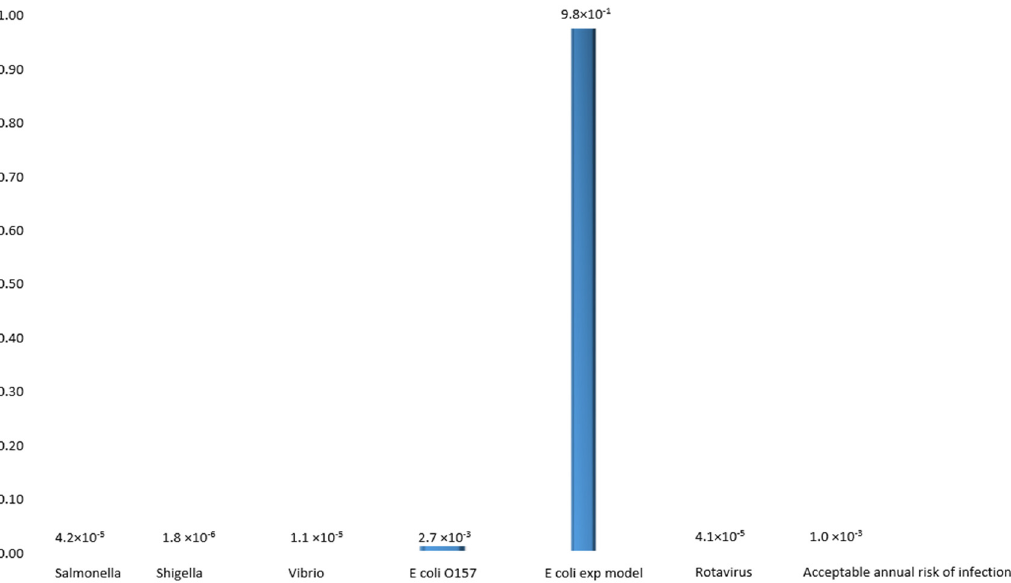
Figure 1. Probability of infection associated with consumption of water infected with a single enteric pathogenic microorganism collected in alternating months.